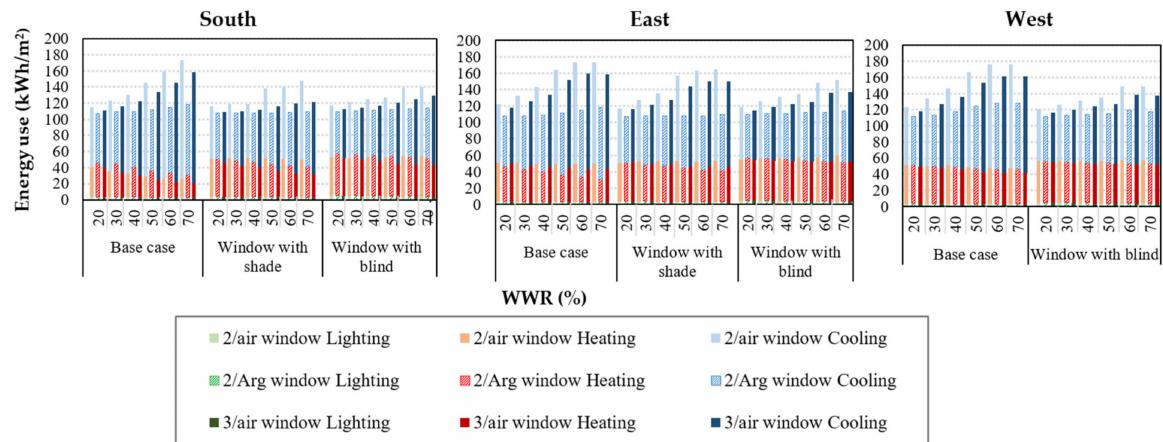
Figure 7. Lighting, cooling, and heating energy use as a function of WWR (%) for three window types (2/air, 2/Arg, and 3/air windows) for south, east, and west orientations of buildings located in Steppe, cold, arid climate